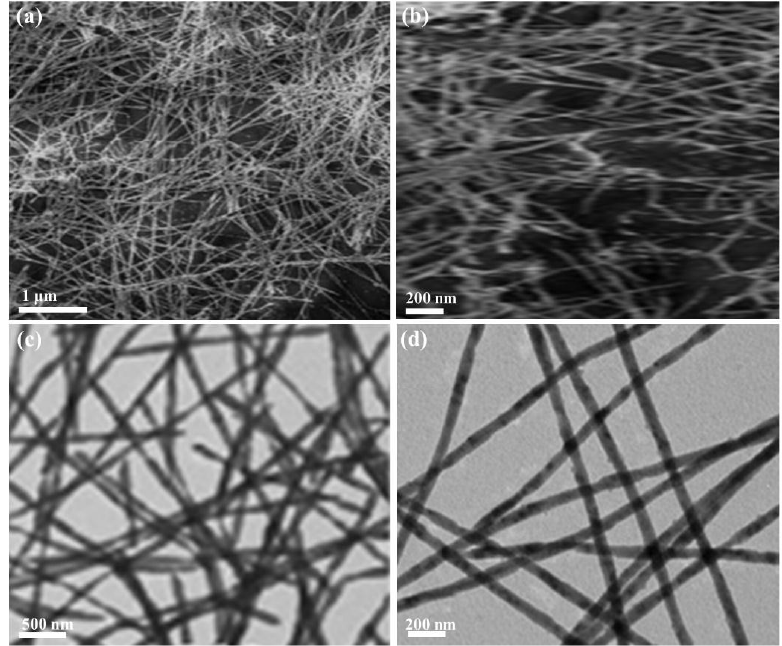
Figure 1. ( a , b ) SEM images and ( c , d ) TEM images of Pd/Cu/CN NWs prepared under typical conditions.